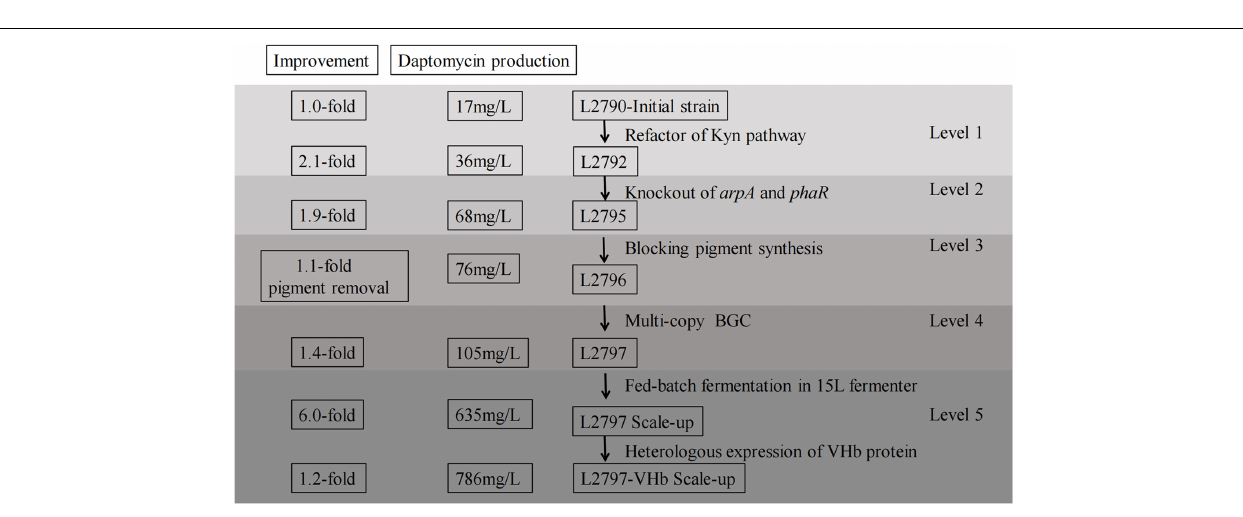
FIGURE 5 | Diagram summarizing multilevel metabolic engineering strategies implemented to daptomycin production and quality. Counting from the right, the first column, the level number for each metabolic engineering approach; the second column, the specific implementation content for each step of combinatorial metabolic engineering strategies from the beginning to the end; the third column, daptomycin production caused by each metabolic engineering approach; the last column, the corresponding fold changes caused by each metabolic engineering